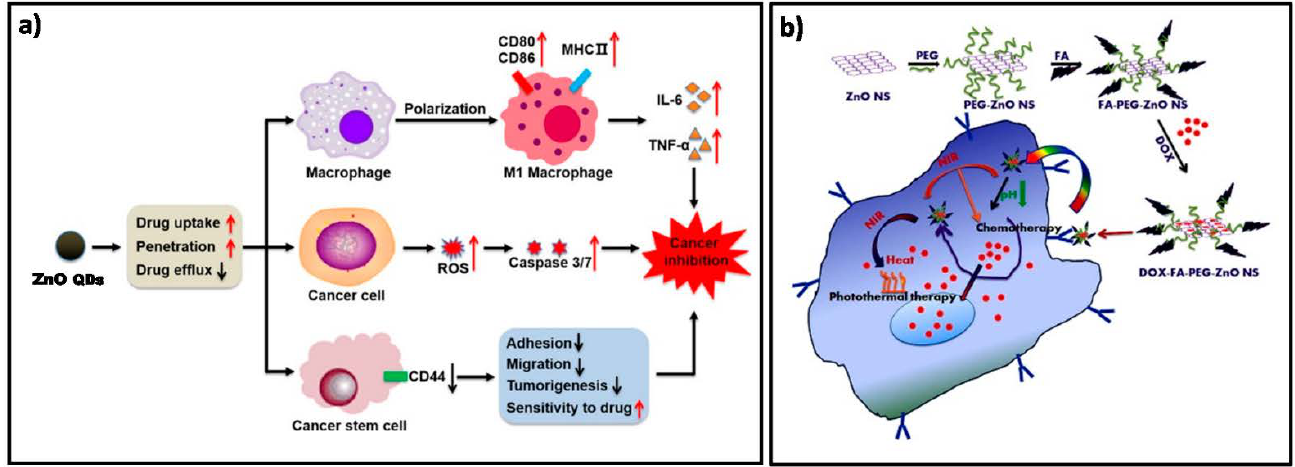
Figure 3. ( a ) Numerous antitumor effects of ZnO quantum dots as a multifunctional anticancer agent [156]. ( b ) Mechanism of action of DOX-FA-ZnO NPs in the treatment of breast cancer [157]. (Re-printed/adapted with permission from refs [156,157]).